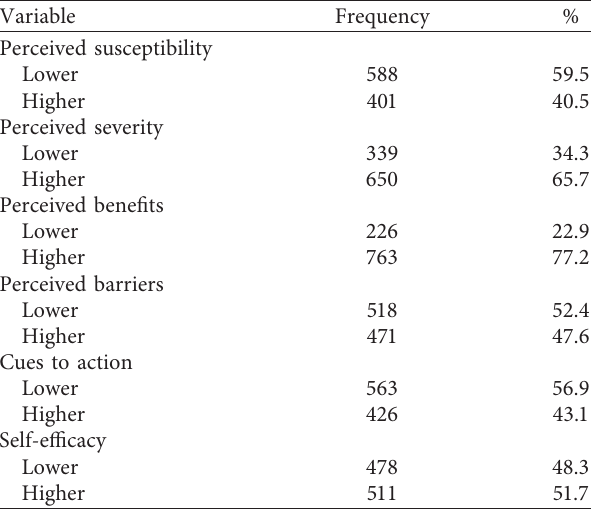
Table 5: Hypertension belief and behavior of patients in Central Ethiopia, 2017 ( n � 989).